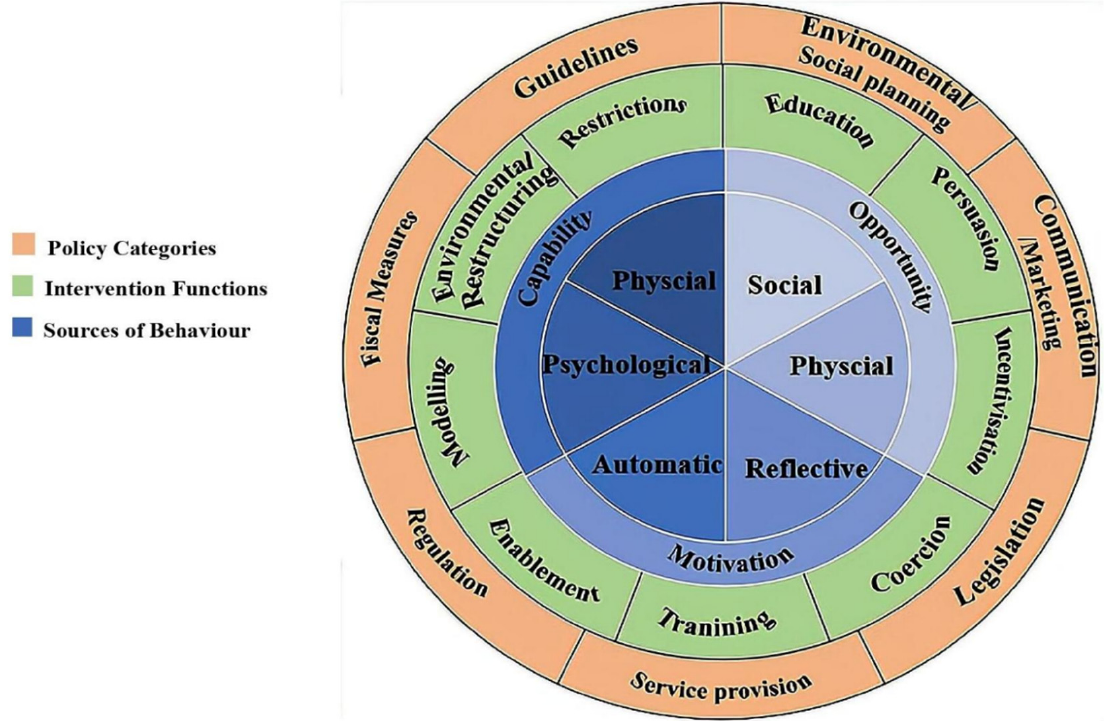
Figure 1. Behavior Change Wheel (adapted from Michie et al. [25] ).